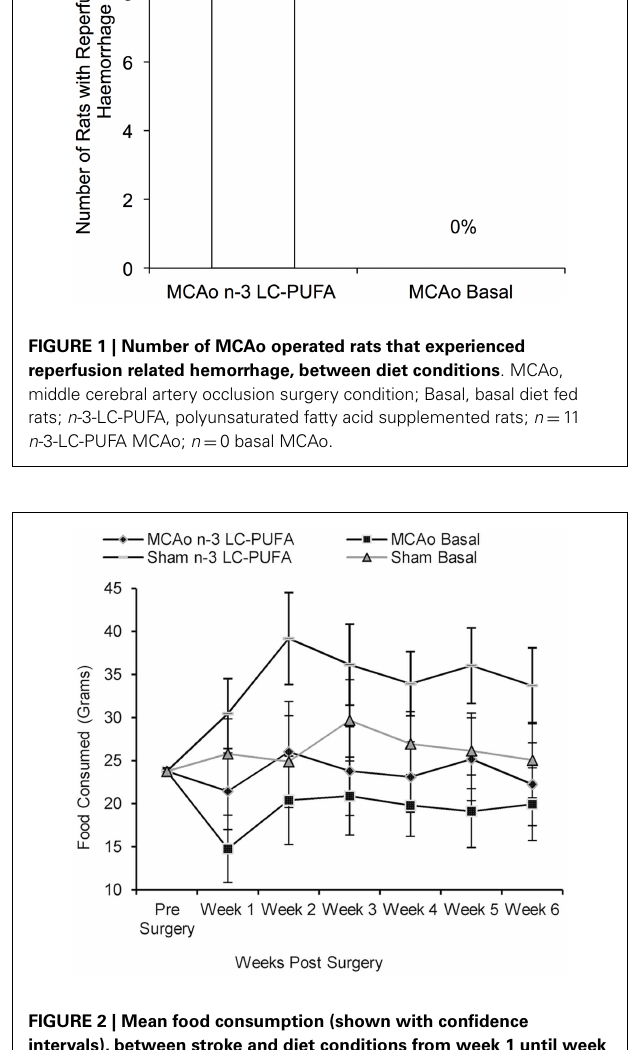
FIGURE 2 | Mean food consumption (shown with confidence intervals), between stroke and diet conditions from week 1 until week 6 post-surgery . MCAo, middle cerebral artery occlusion surgery condition; Sham, Sham surgery condition; Basal, basal diet fed rats; n -3-LC-PUFA, polyunsaturated fatty acid supplemented rats; week 1, week one post-surgery; week 2, week two post-surgery; week 3, week three post-surgery; week 4, week four post-surgery; week 5, week five post-surgery; week 6, week six post-surgery. n = 11 n -3-LC-PUFA MCAo; n = 13 Basal MCAo; n = 12 n -3-LC-PUFA sham; n = 12 Basal Sham.